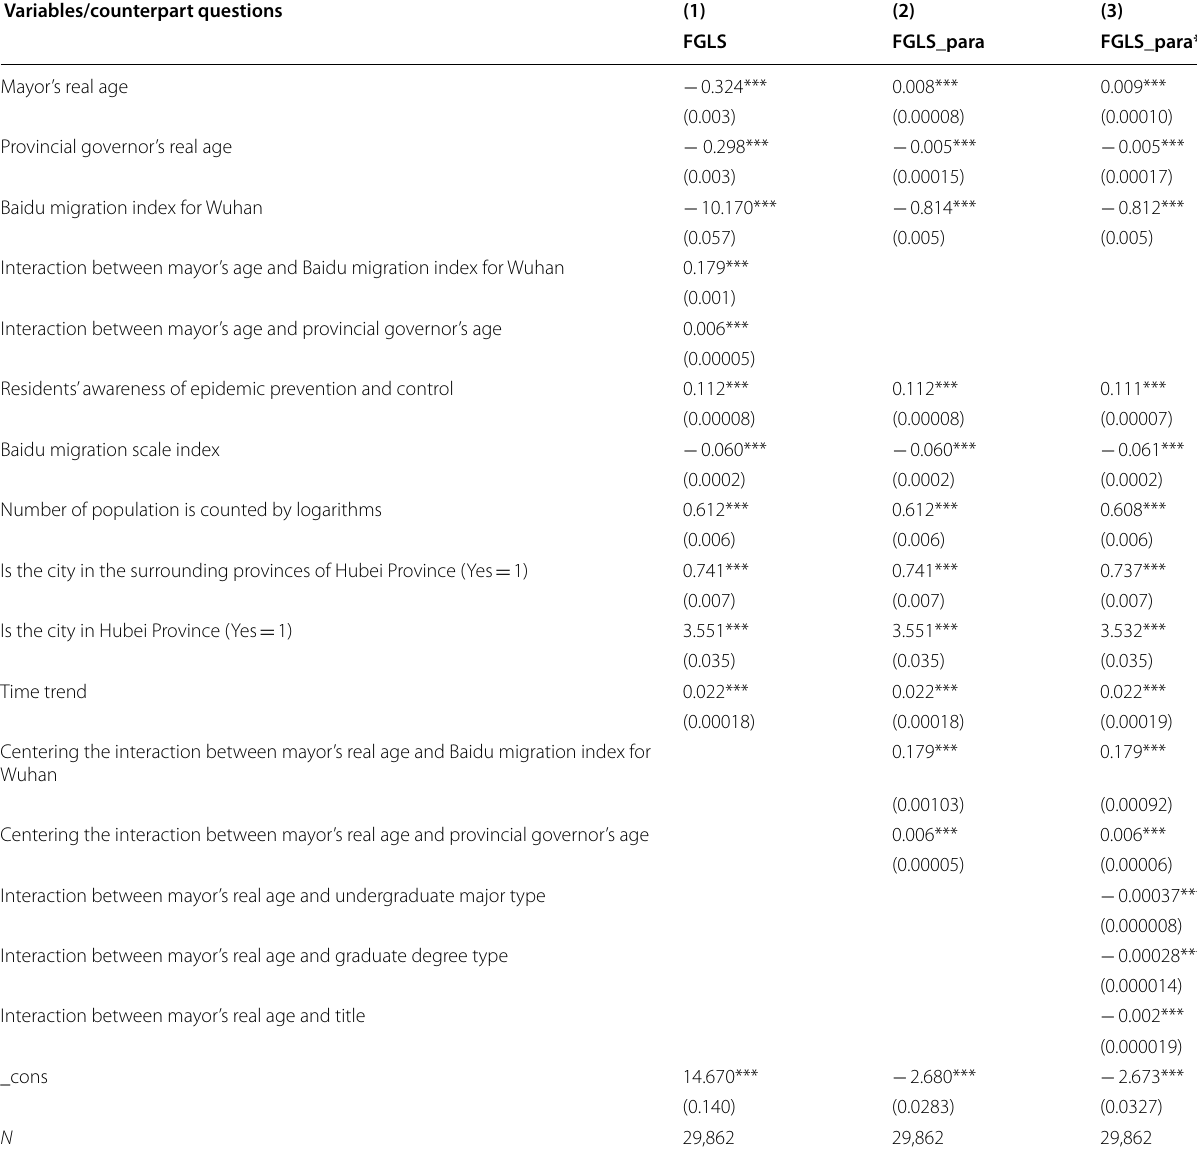
Table 4 Robustness test results for replacing core explanatory